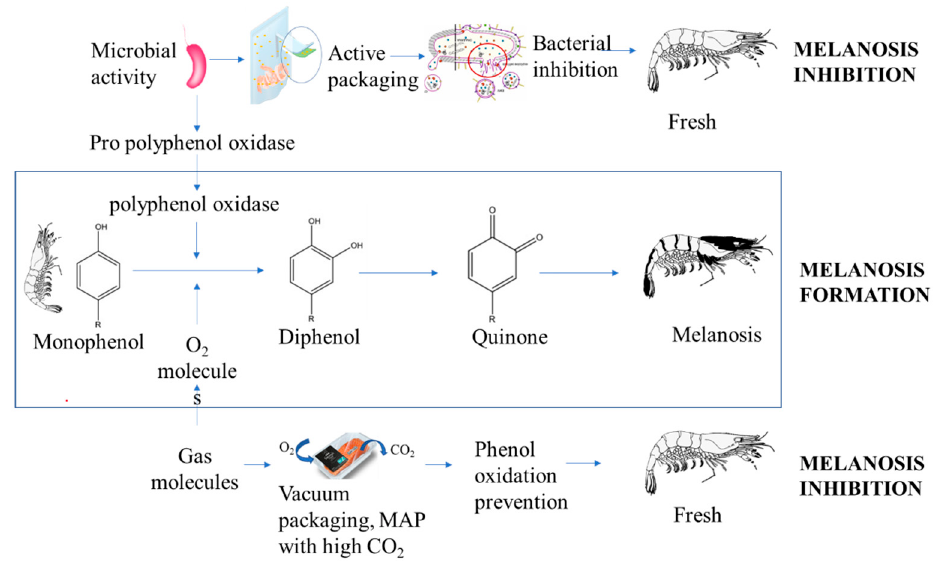
Figure 2. Melanosis formation through polyphenol oxidation and its prevention via microbial inhibition and O 2 removal using packaging technology.